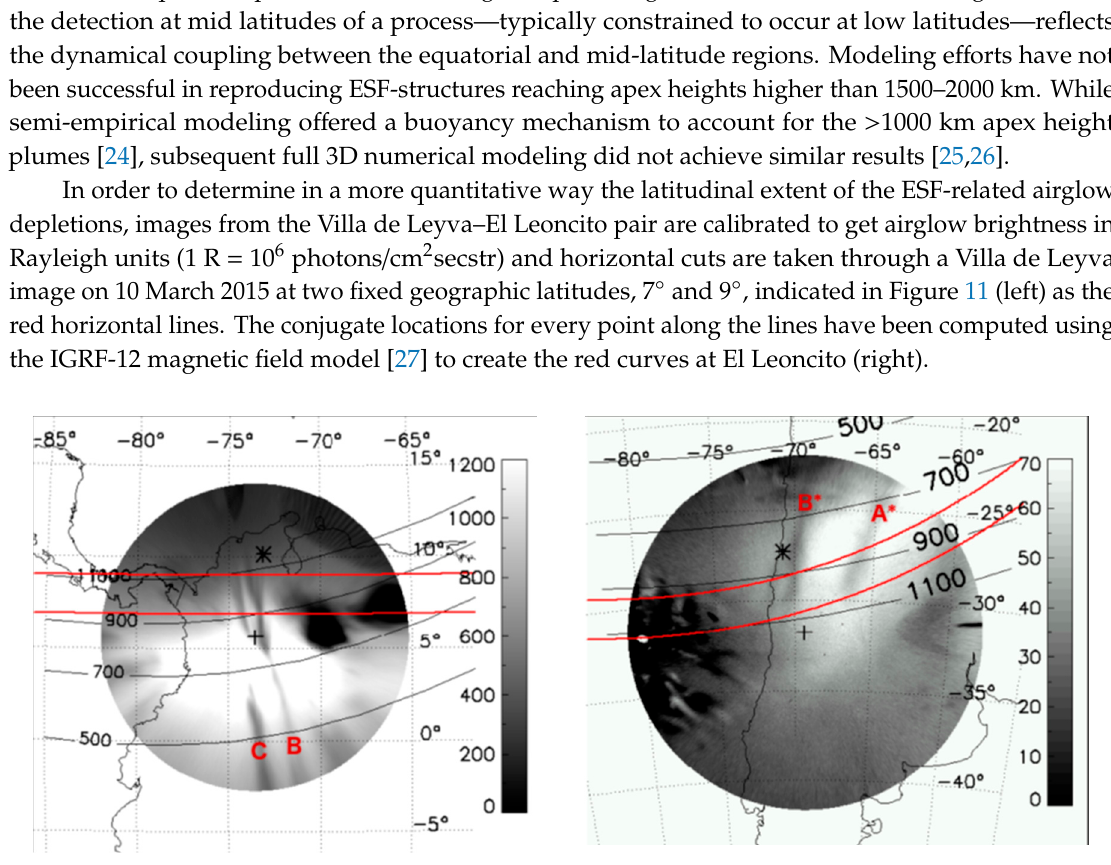
Figure 11. ( left ) A 630.0 nm image taken with the Villa de Leyva ASI at 04:13 UT on 29 November 2014. The red lines represent cuts through the image at a constant geographic latitude of 9° N and 7° N. The red letters mark the different depletions. The bright airglow between ~0 and 5° is the northern crest of the equatorial ionization anomaly; ( right ) simultaneous image from the El Leoncito ASI. The red curves are the conjugate locations of the cuts in the Villa de Leyva image. Solid black contours are lines of constant magnetic apex altitude in kilometers. The gray scale associated with each image shows the emission in Rayleighs. Depletions B and B * are conjugate structures.